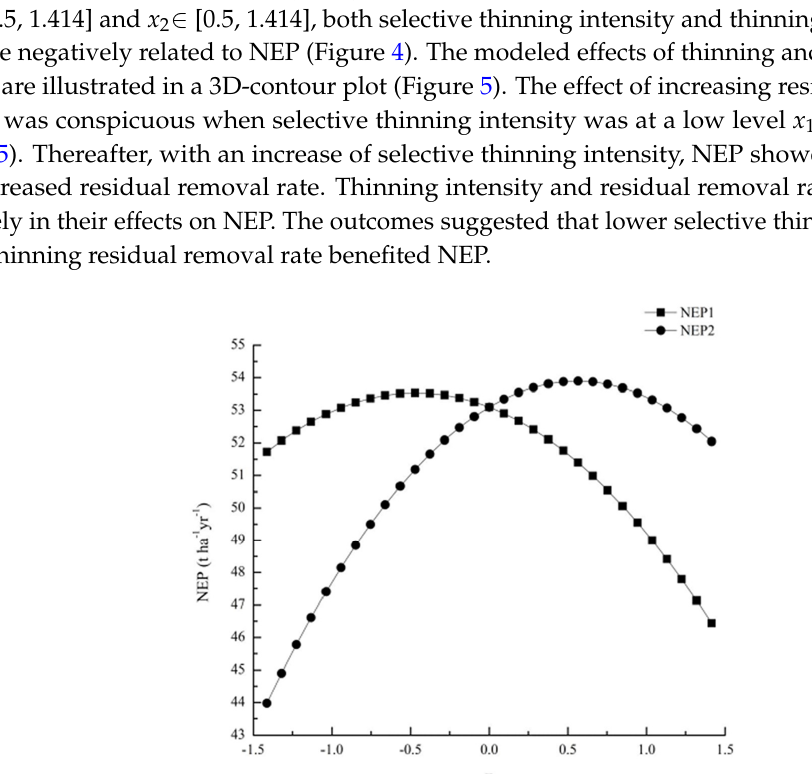
Figure 5. Contour plot for NEP from selective thinning ( x 1 ) and residual removal ( x 2 ). 3.7. Optimization Forest Management Measures for NEP Each independent variable (thinning intensity, residual removal rate) was individually increased or decreased in an attempt to find the maximum response in NEP. Once the optimal value was found separately for thinning intensity and residual removal rate, the value was selected as the condition for obtaining the overall maximum NEP. Our analysis demonstrated that the maximum NEP (53.93 t ∙ ha − 1 ∙ year − 1 ) was achieved when the independent variables were x 1 = − 0.17 and x 2 = 0.48. To verify these index values, the codes for the independent variables were incorporated into